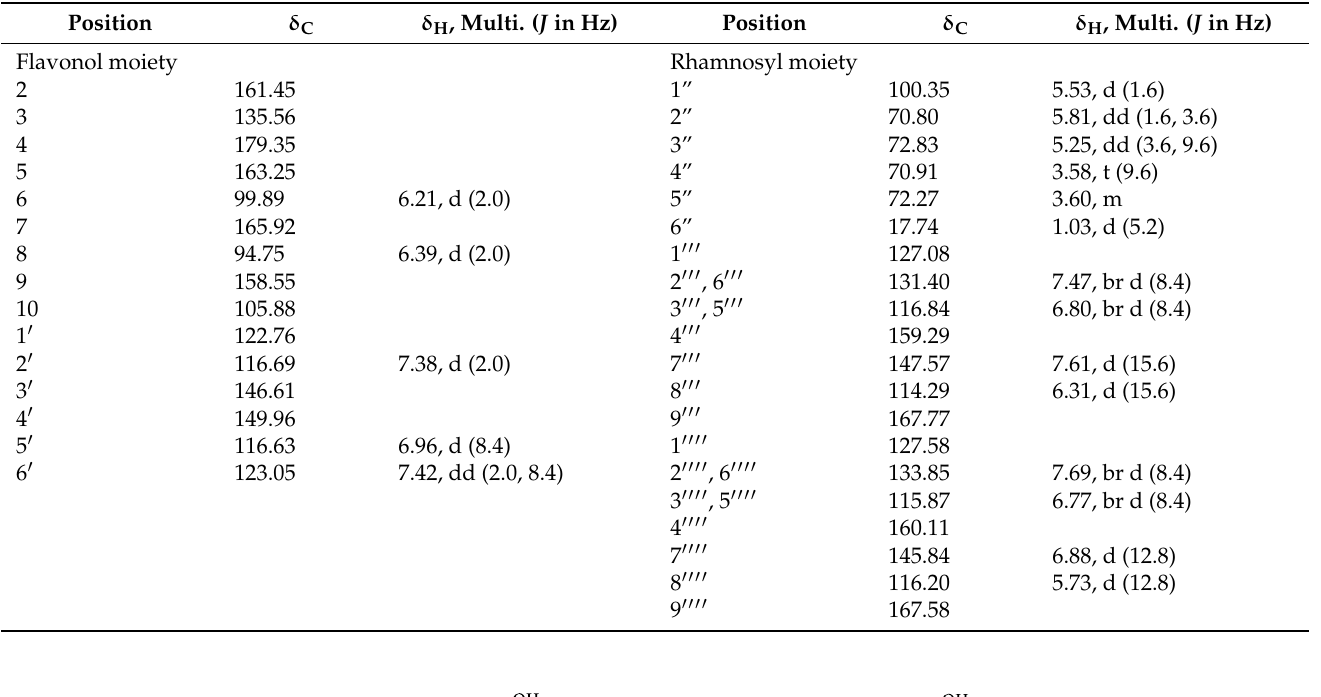
Table 1. NMR spectroscopic data (in CD 3 OD) for compound 1 .